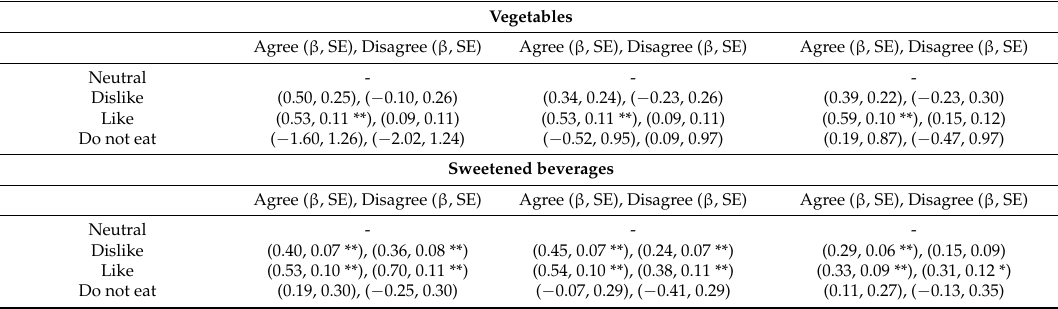
Table 3. Cont. Vegetables